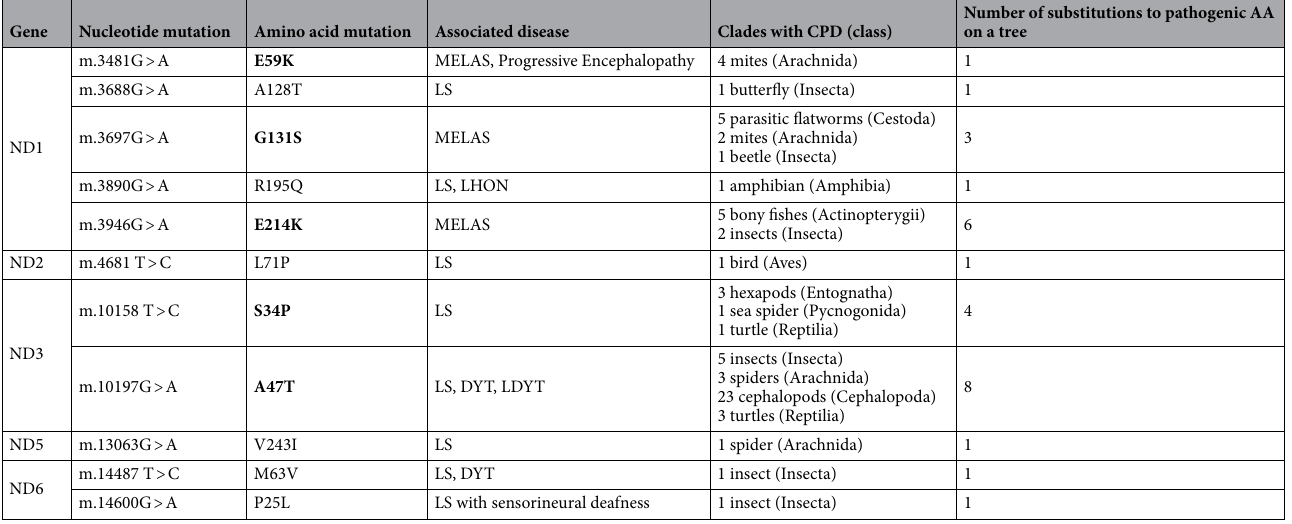
Table 1. CPD in mitochondrially encoded Complex I proteins. Variants that are considered in details below are shown in bold. MELAS—Mitochondrial encephalomyopathy, lactic acidosis, and stroke-like episodes; LS— Leigh Syndrome; LHON—Leber’s hereditary optic neuropathy; DYT – dystonia; LDYT—Leber’s disease and